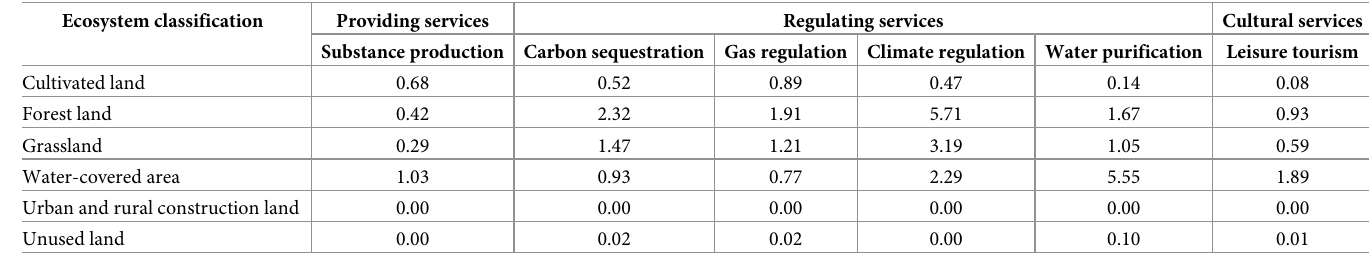
Table 3. The equivalent value per unit area for various ecosystem services. Ecosystem